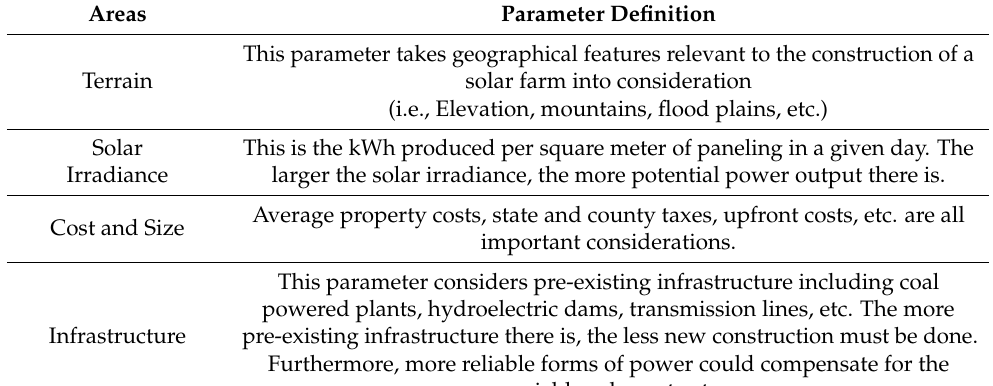
Table 2. Parameter